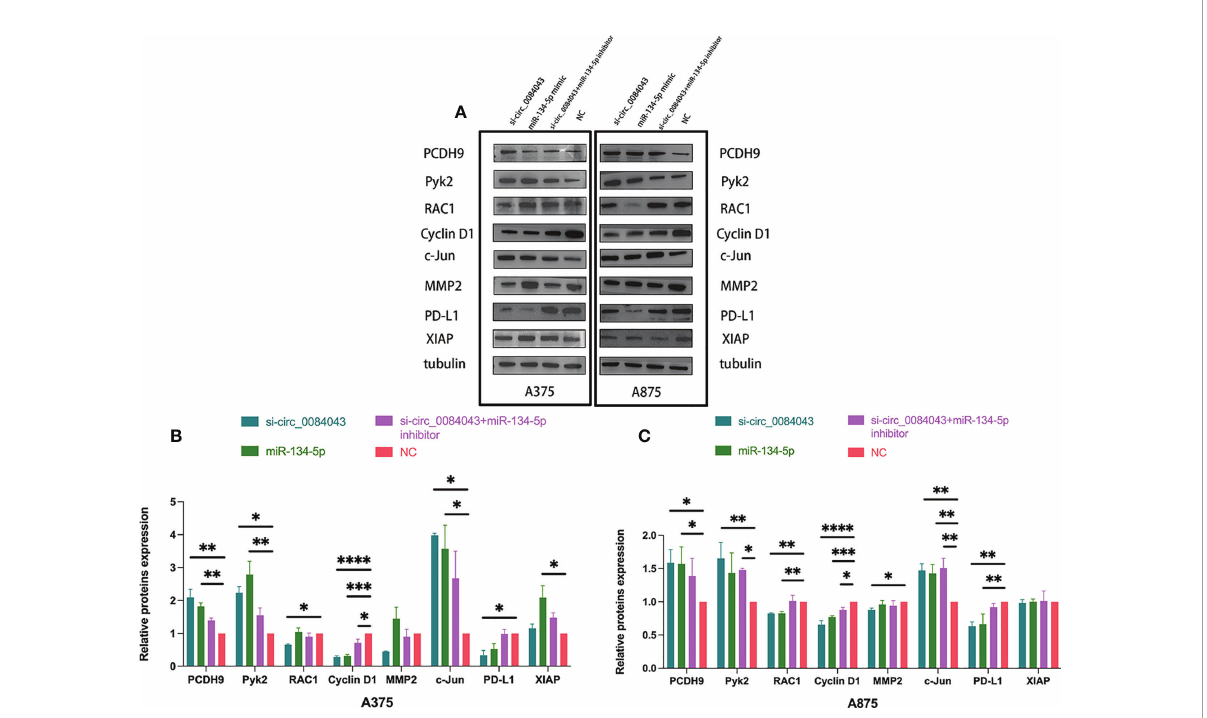
FIGURE 8 Western blot was used to detect the expression levels of PCDH9, Pyk2, RAC1, Cyclin D1, MMP2, c-Jun, XIAP, and PD-L1 in melanoma cells after transfection for 48 h (A – C) . Data represent mean ± SD from three independent experiments. * p < 0.05, ** p < 0.01, *** p < 0.001, and **** p < 0.0001 compared groups using one-way ANOVA followed by least signi fi cant difference post-hoc